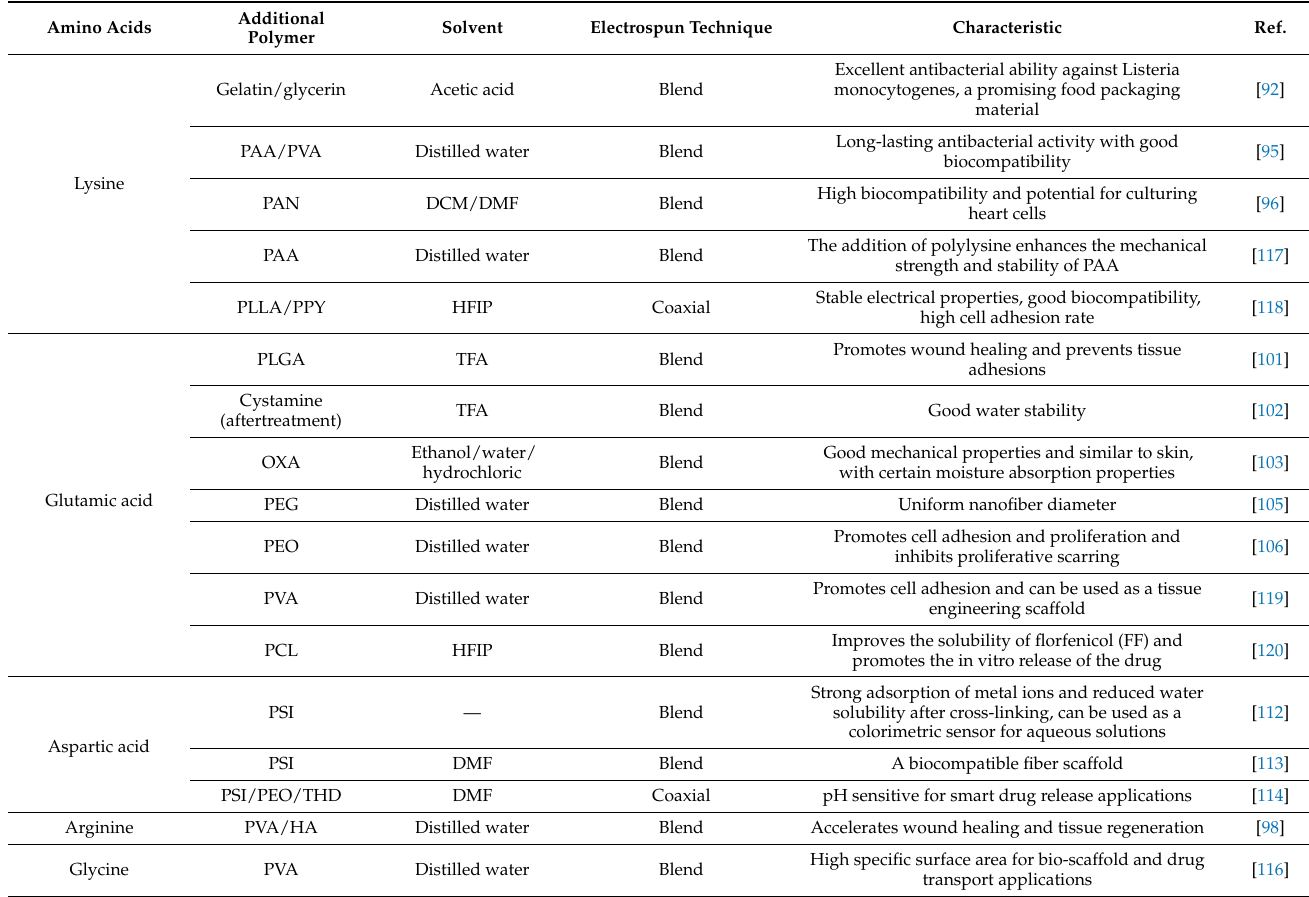
Table 2. Electrospinning conditions and characteristics of common polar amino